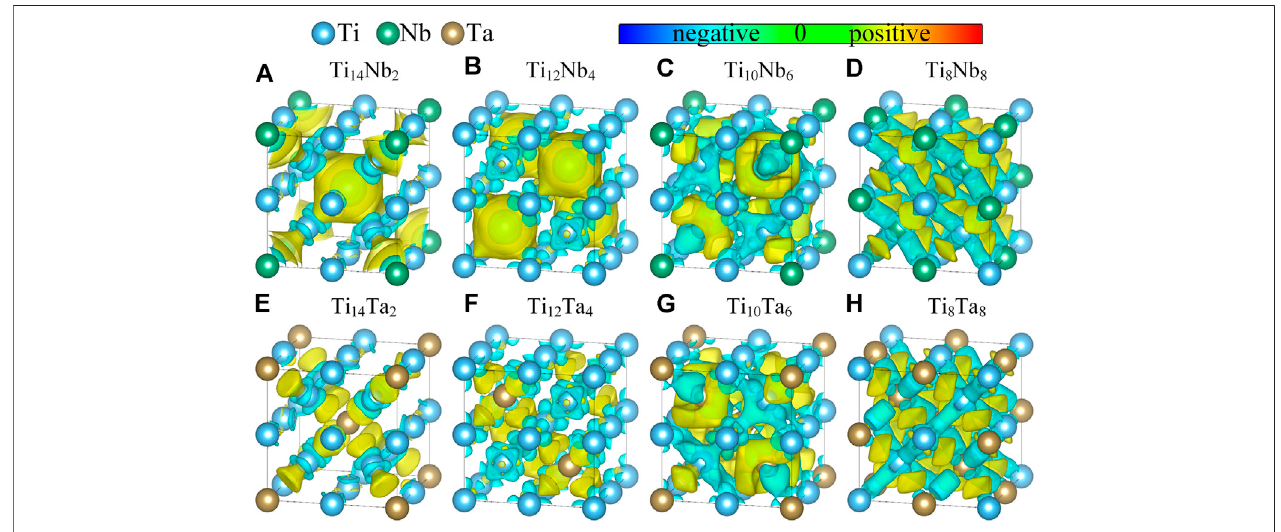
FIGURE 11 | Difference charge densities of β -Ti X ( X = Nb, Ta) alloys. (A) Ti 14 Nb 2 ; (B) Ti 12 Nb 4 ; (C) Ti 10 Nb 6 ; (D) Ti 8 Nb 8 ; (E) Ti 14 Ta 2 ; (F) Ti 12 Ta 4 ; (G) Ti 10 Ta 6 ; (H) Ti 8 Ta 8 . The value of all the isosurface level is 0.0051e/Å 3